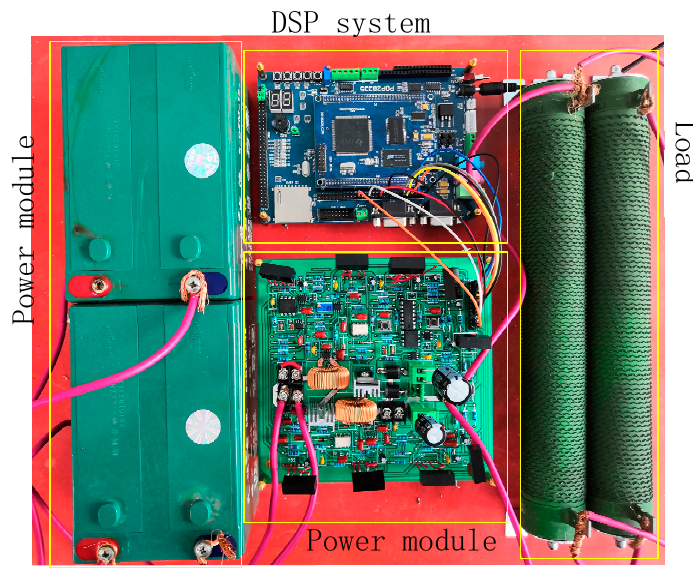
Figure 15. Design power module prototype.